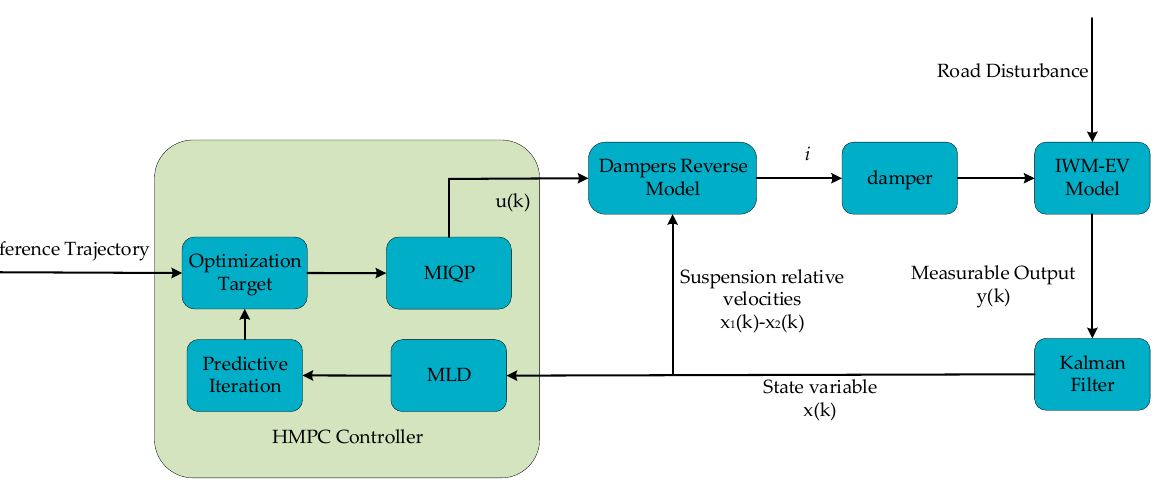
Figure 17. Hybrid model predictive controller (HMPC) control scheme.